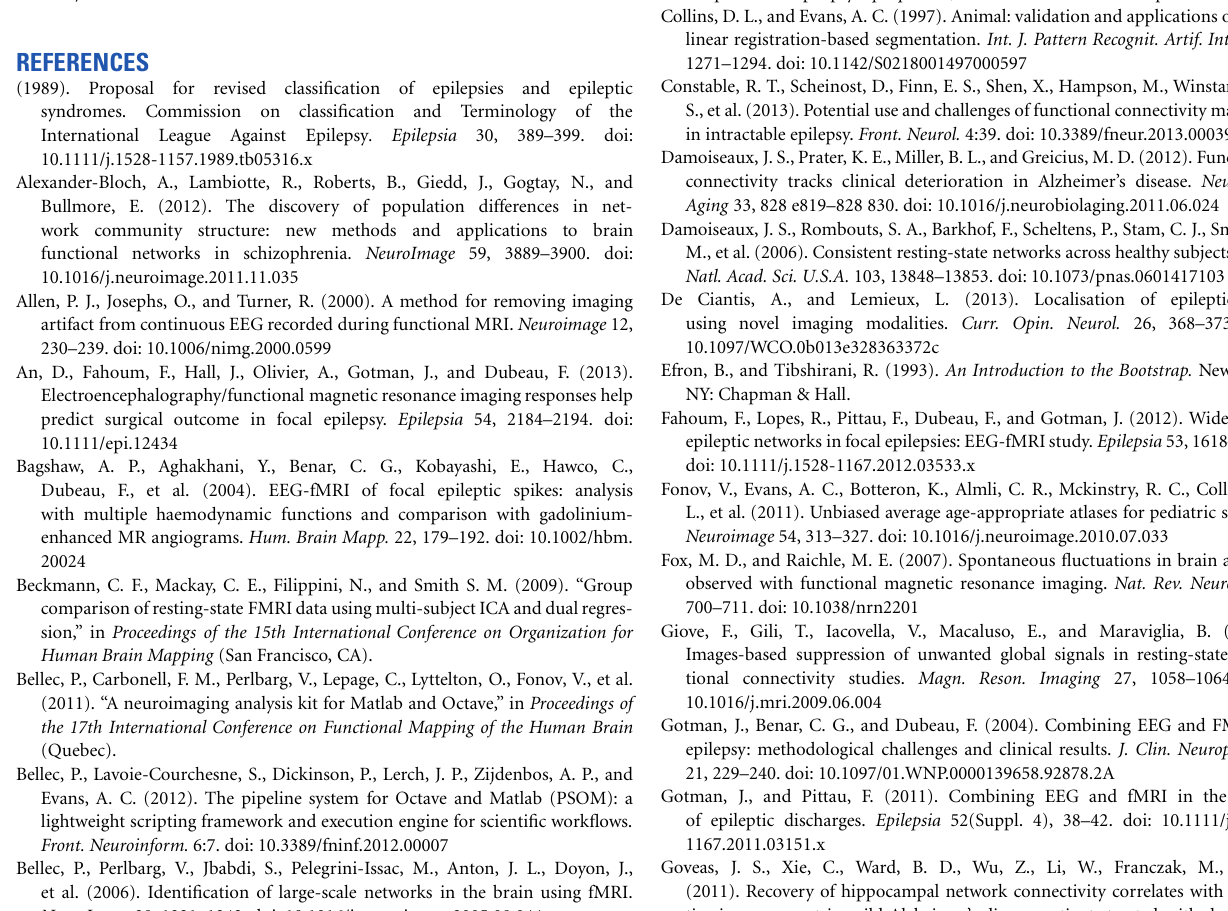
Figure S1 | Data workflow used to generate the combined significant stability-map Cmap n comparing, for one particular network, the trimmed stability map of one subject vs. the population of controls. A binary mask Zmask n assessing significant changes in local stability is first estimated. This binary mask is then applied to the subject trimmed stability map centered using the mean stability of all controls. Cmap n allows the identification of most stable regions showing significant changes in stability when compared to the average of controls. In this example, Cmap n of the auditory network identified an increase in stability in bilateral Thalami. Note that the most posterior region also identified in Zmask n was not detected in Cmap n , because it was associated with very low stability values. Figure S2 | Method used to combine some structured noise time-series with the original fMRI signal of the sensory-motor and auditory network time-series. This process is repeated for each region of these two networks located inside the red area corresponding to the simulated perturbed zone. The structured noise consisted in the averaged time-series of the visual network of an independent control, thus introducing additional correlations between the auditory and sensory-motor